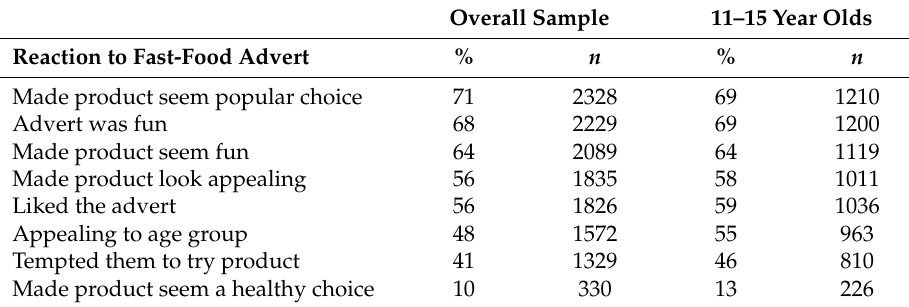
Table 4. Positive reactions to the confectionery